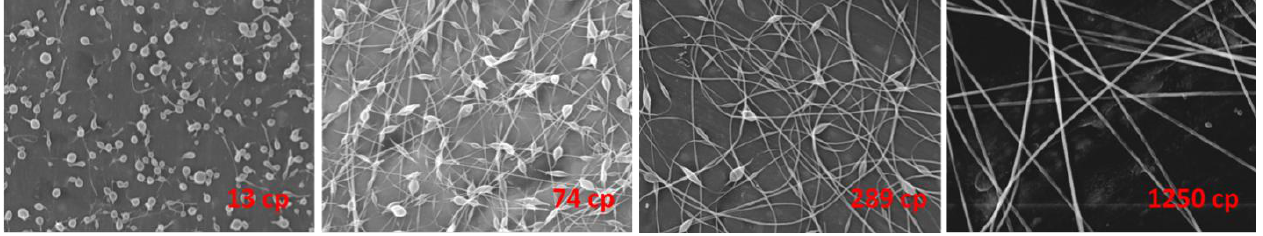
Figure 2. Evolution of the morphology of polymer fibers upon increase of solution viscosity. SEM images of poly(ethyleneoxide) fibers (each image shows a 20 µm wide area), together with viscosity value (in red). Left: polymer drops and fibers with spherical beads. From left to right, as the viscosity progressively increases, the average distance between beads on the fibers becomes larger and the shape of the beads changes from spherical to spindle-like, till reaching uniform fibers. Adapted with permission from [30]. Copyright (1999) by